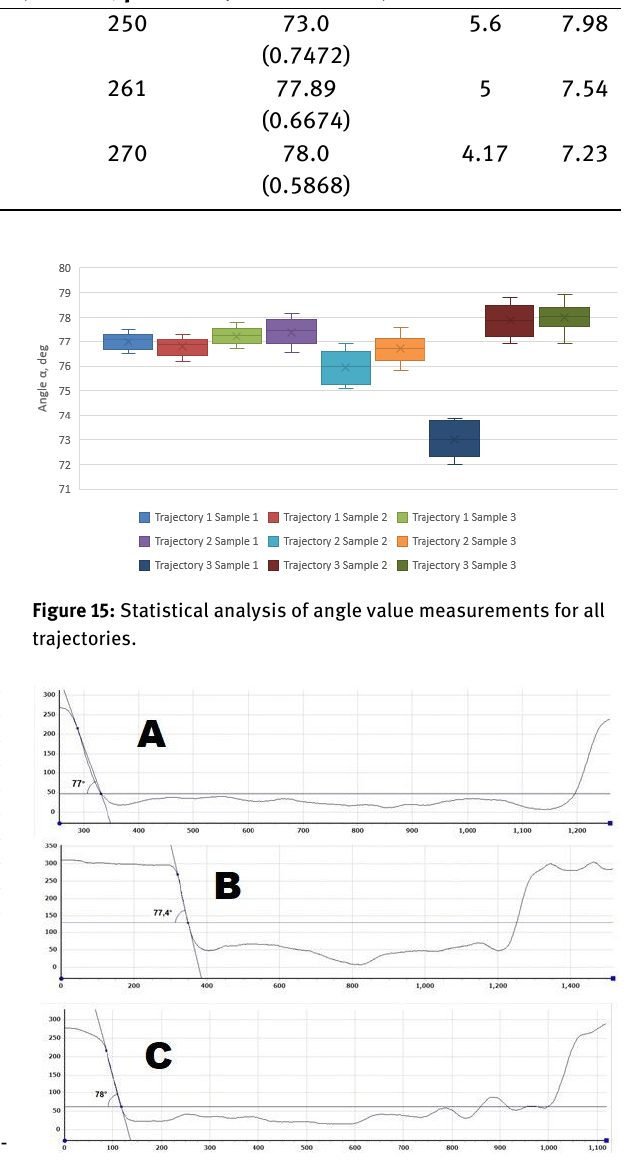
Figure 16: 2D profiles of chosen samples for each trajectory (A – trajectory 1, B – trajectory 2, C – trajectory